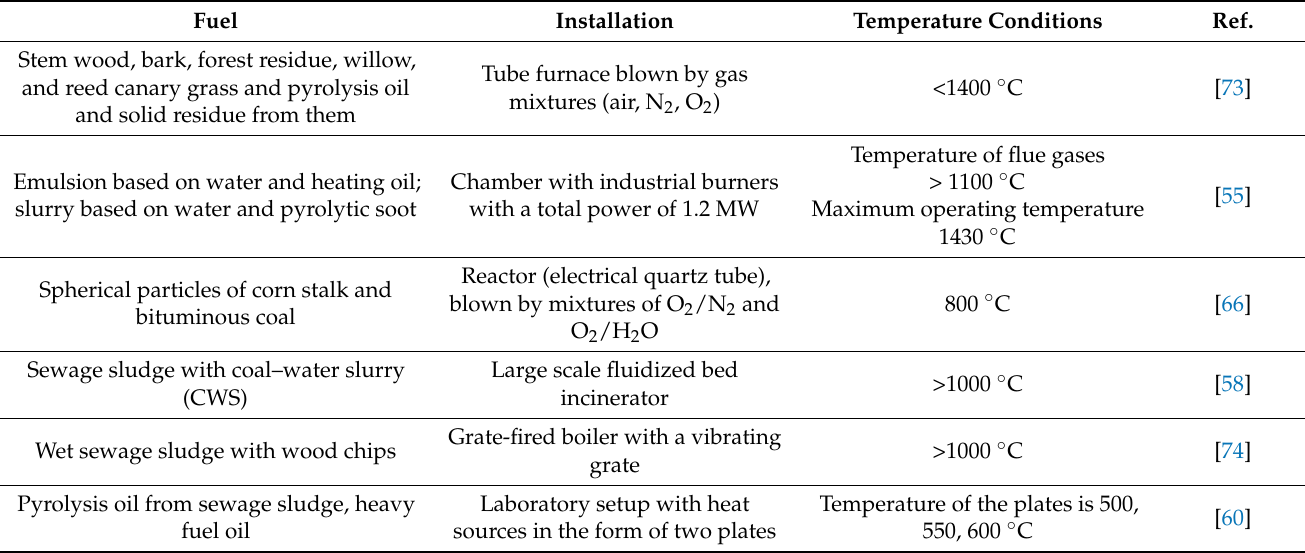
Table 2. Experimental plants for the study of ignition and combustion of non-conventional